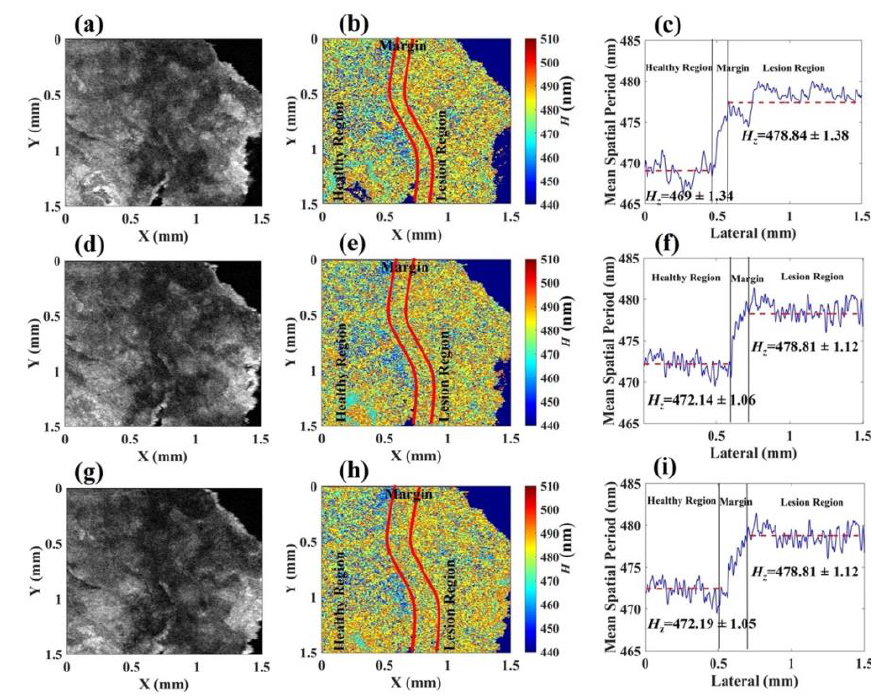
Figure 13. ( a , d , g ) Intensity-based OCT images of human skin at the depths of ∼ 200 µ m, 400 µ m, and 600 µ m respectively. ( b , e , h ) The corresponding nsOCT en face images with spatial period mapping, presenting the dominant structural size. The healthy, marginal, and lesional regions are separated by the red lines. The color bar of the nsOCT en face images represents the spatial periods in nanometers. Plots ( c , f , i ) show changes in the mean dominant spatial period of the structure between the two regions, defining an intervening marginal area in the nsOCT en face images [44].